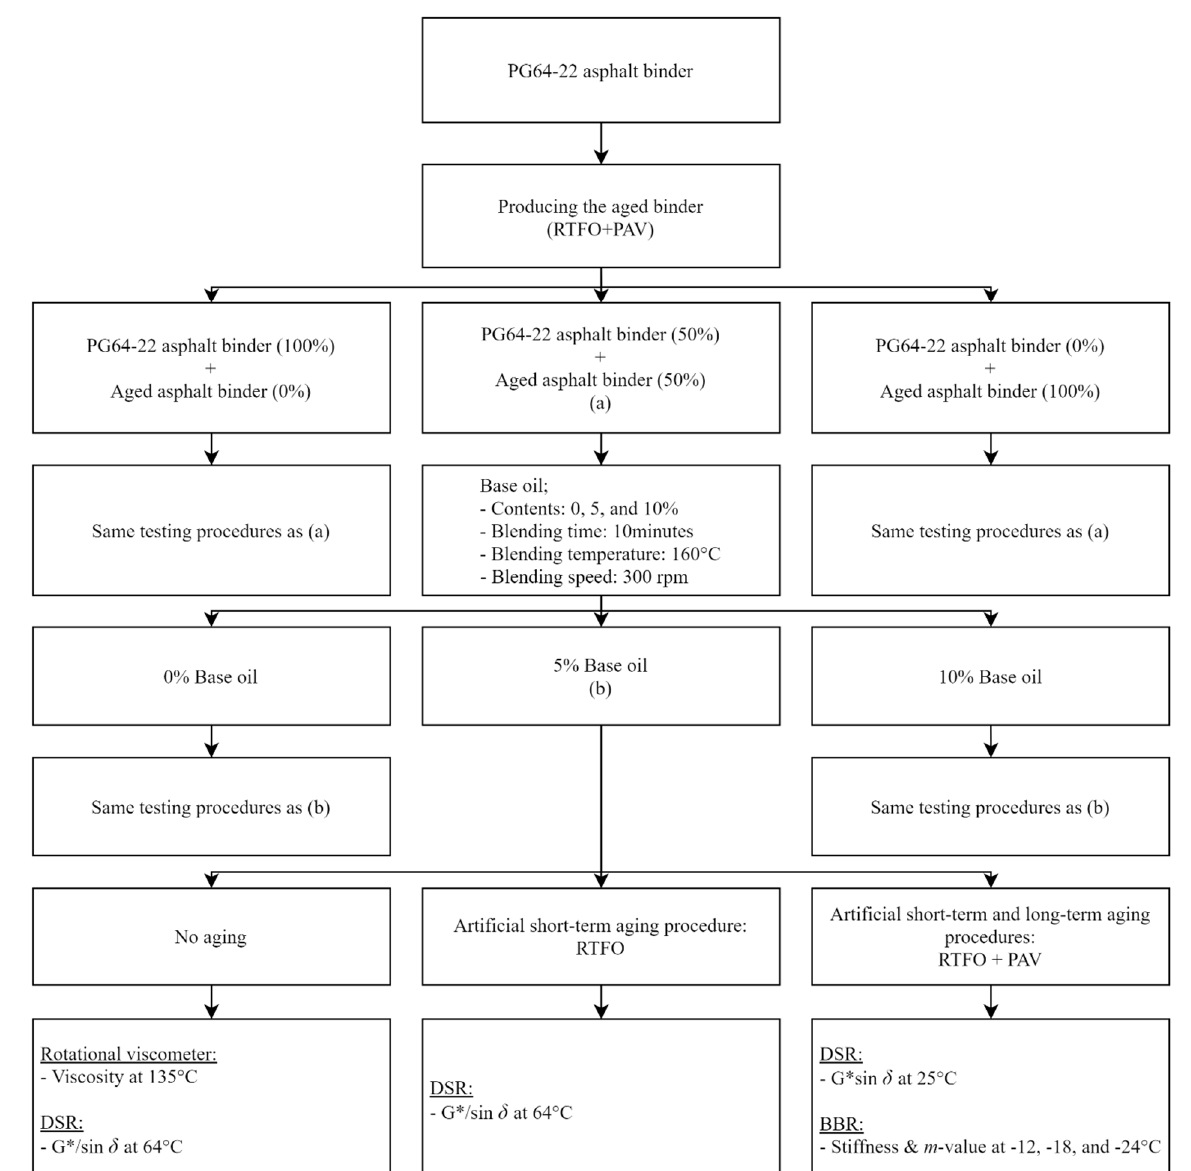
Figure 1. Flow chart of experimental design procedure in this study.